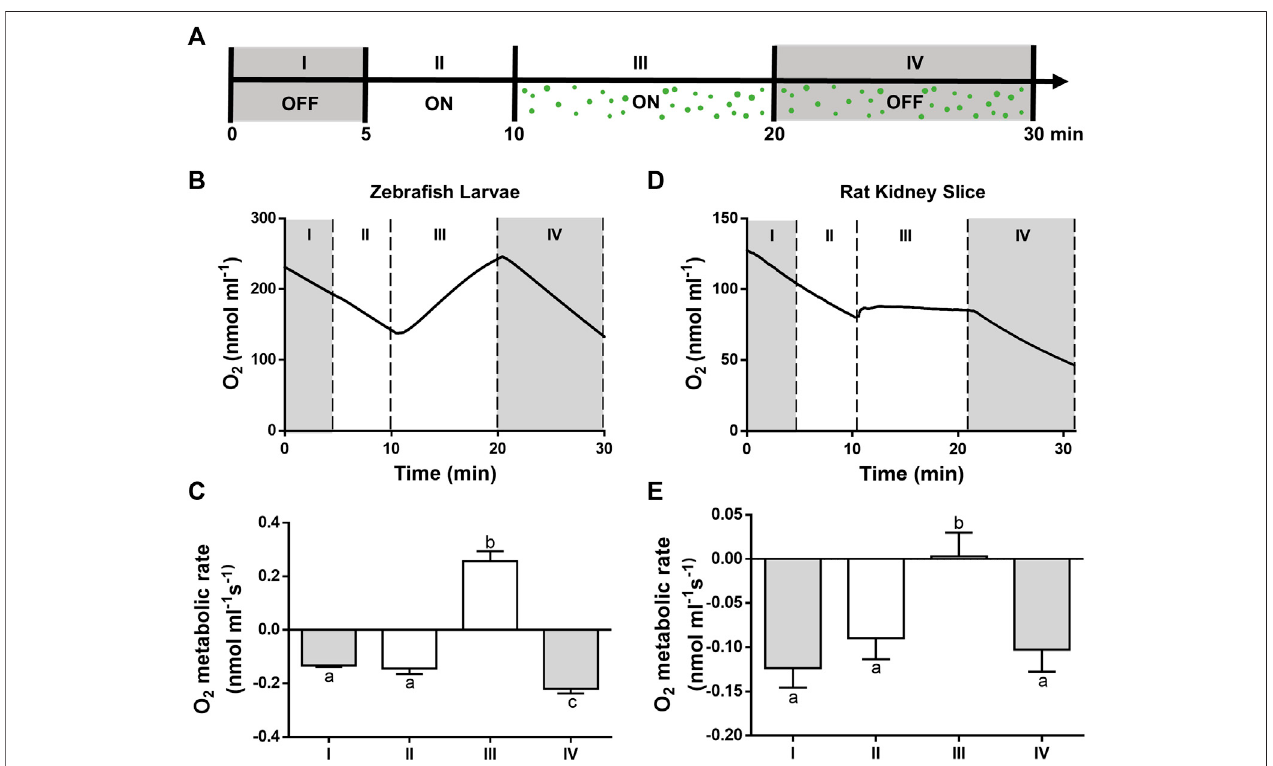
FIGURE 4 | Oxygenation capacity of the photosynthetic solution. Oxygen concentrations were measured for 5 min in darkness (I, OFF) or light (II, ON). Then, microalgae were incorporated and measurements were performed for 10 min in the presence (III, ON) or absence (IV, OFF) of light (A) . In the absence of light or microalgae (I, II and IV) a negative slope of the curve was seen for both, zebra fi sh larvae (B,C) and kidney slices (D,E) , while in the presence of light and microalgae, the slope became positive for the larvae and nearly fl at for the slices. A representative curve is shown for each experiment (B – D) and their metabolic rates calculated from the slopes (C – E) . Data are expressed as mean ± SD; N (cid:2) 3; different letters in C and E indicate signi fi cant differences with p < 0.05 (one-way ANOVA followed by Tukey´s